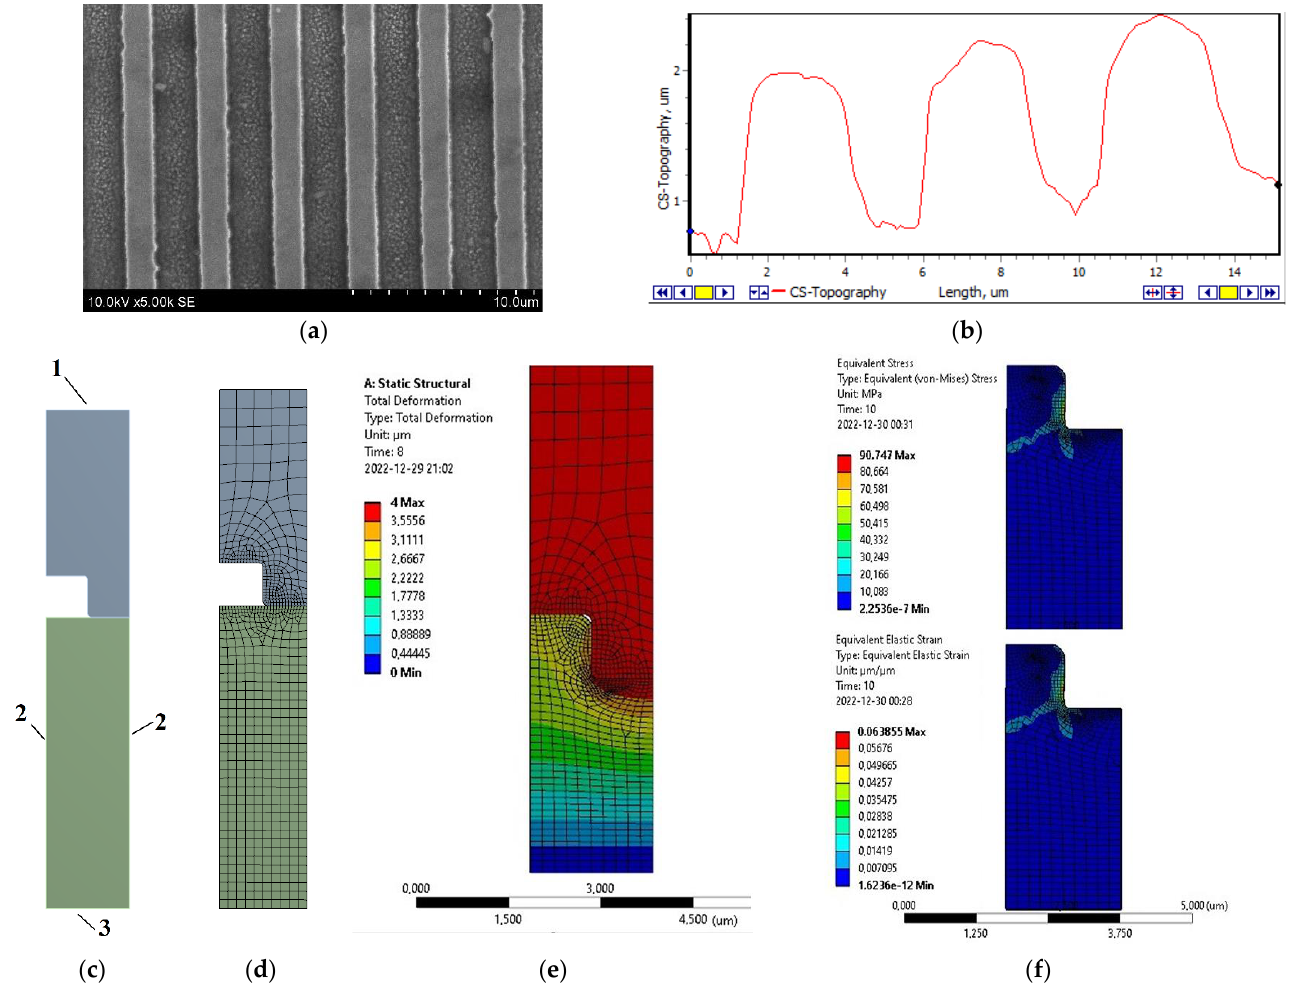
Figure 4. Images of the master matrix: ( a ) SEM image of the master matrix, ( b ) AFM topography surface profiles; Finite element analysis: ( c ) model with boundary conditions: 1 — remote displacement, 2 — frictionless support, 3 — fixed support; ( d ) model with mesh; ( e ) total deformation; ( f ) equivalent stress and equivalent elastic strain.